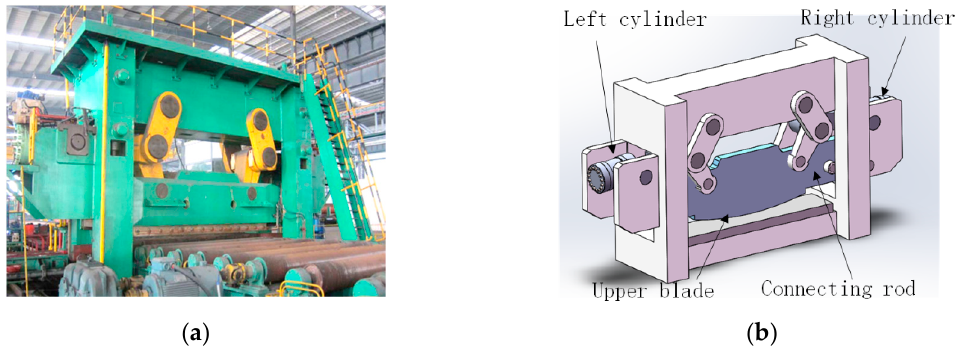
Figure 1. ( a ) Photograph of a hydraulic rolling shear; ( b ) schematic of its mechanism.